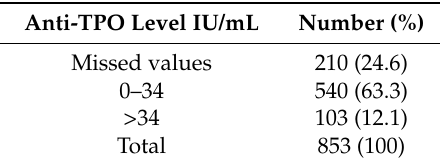
Table 4. Thyroid peroxidase antibody (anti-TPO) positivity.